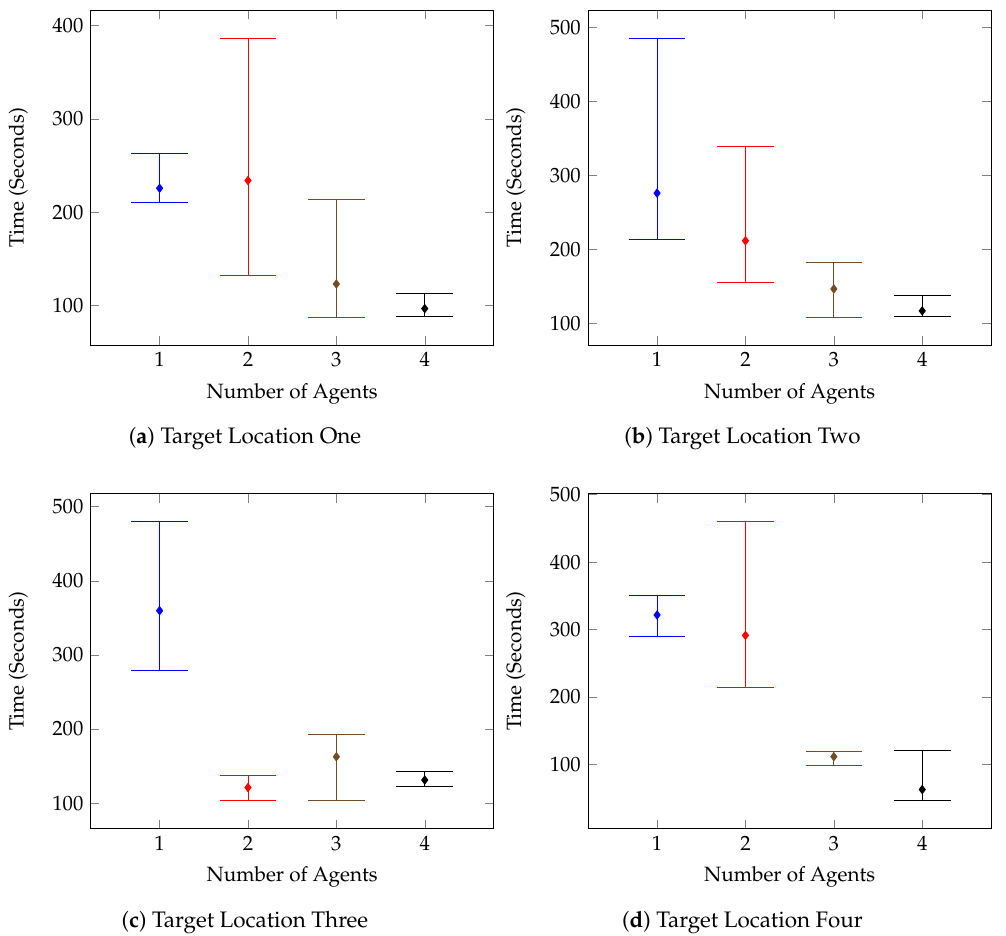
Figure 12. Number of Agents vs. Maximum, Mean and Minimum Times (Seconds)-Test Environment